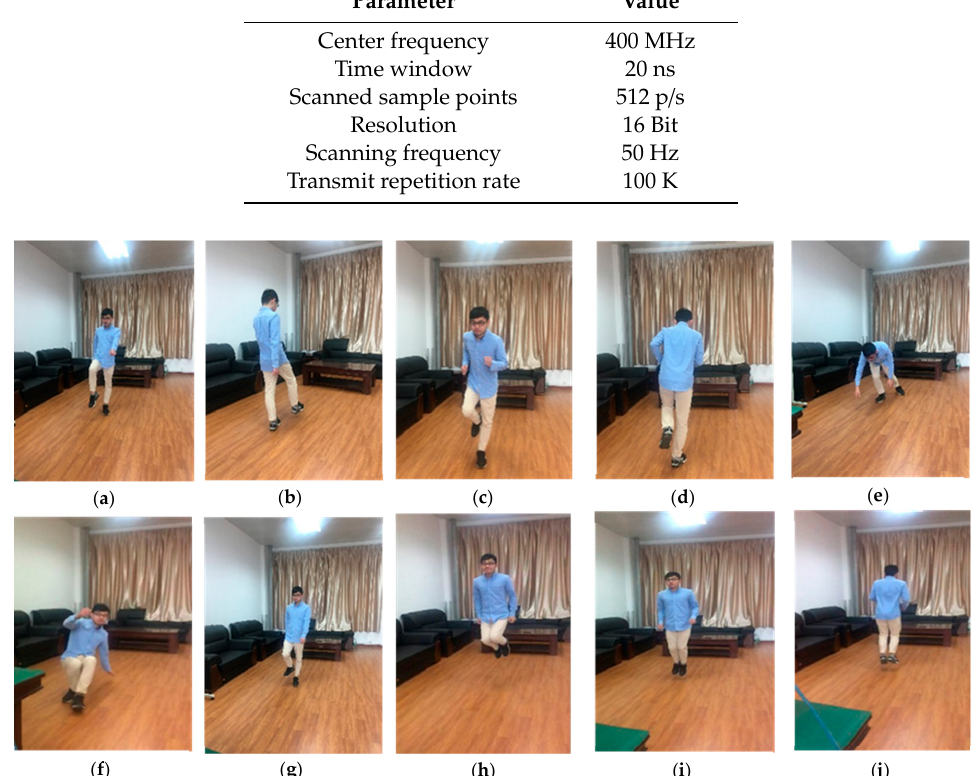
Figure 3. Ten di ff erent types of human motion measurement scenes, ( a ) walk forward of human motion Figure 3. Ten different types of human motion measurement scenes, ( a ) Walk forward of human motion measurement scenes, ( b ) Walk backward of human motion measurement scenes, ( c ) Run measurement scenes, ( b ) walk backward of human motion measurement scenes, ( c ) run forward of forward of human motion measurement scenes, ( d ) Run backward of human motion measurement human motion measurement scenes, ( d ) run backward of human motion measurement scenes, ( e ) fall scenes, ( e ) Fall forward of human motion measurement scenes, ( f ) Fall backward of human motion forward of human motion measurement scenes, ( f ) fall backward of human motion measurement measurement scenes, ( g ) Walk around of human motion measurement scenes, ( h ) Jump up and down scenes, ( g ) walk around of human motion measurement scenes, ( h ) jump up and down of human of human motion measurement scenes, ( i ) Jump forward of human motion measurement scene, motion measurement scenes, ( i ) jump forward of human motion measurement scene, ( j ) jump backward ( j ) Jump backward of human motion measurement scenes. of human motion measurement